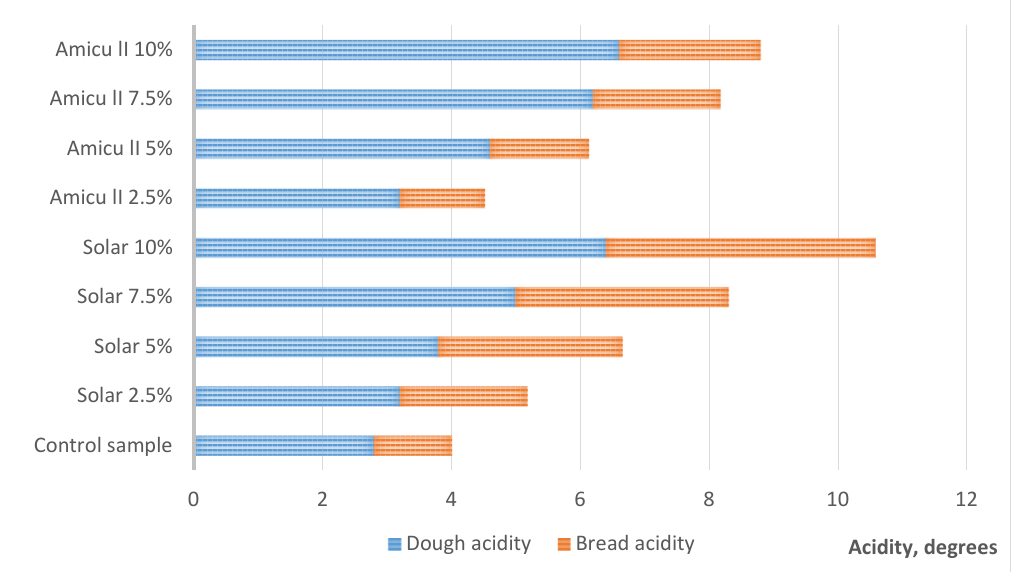
Figure 7. The influence of Jerusalem artichoke flour addition on the change in the acidity of bread compared to the acidity of the